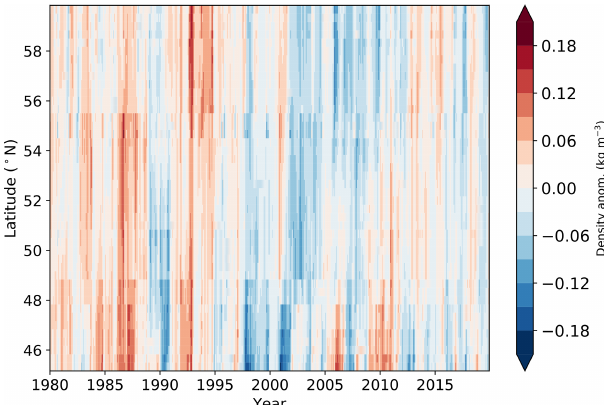
Figure 4. Time series Hovmöller plot of GODAS mean density anomaly, averaged over depth levels 0–600m, at the shelf edge be- tween 45 and 60 ◦